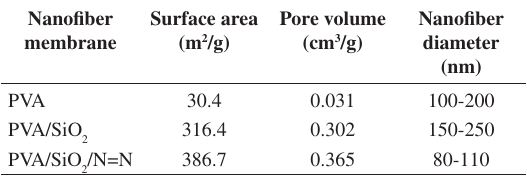
Table 2. Physical properties of nanofiber